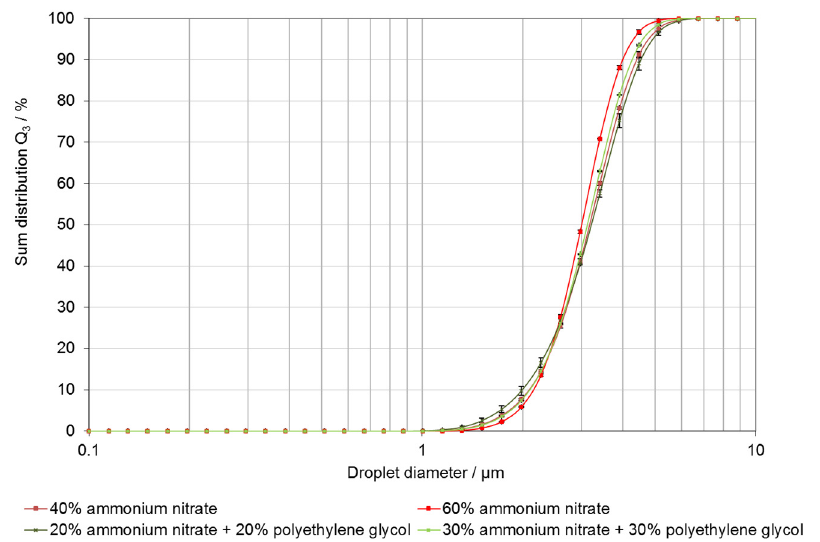
Figure 3. Sum distributions of the droplet sizes of all inner emulsions. Each emulsion was measured threefold.